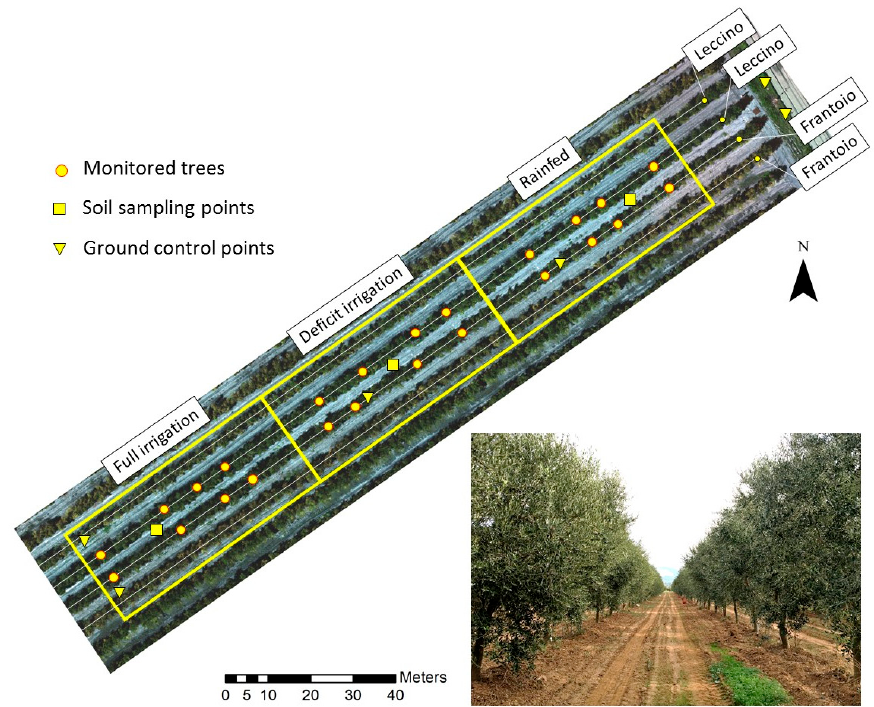
Figure 1. The olive orchard used for the experiment located at San Vincenzo (Livorno, 43.0551° N; 10.5490° E). The three yellow rectangles indicate the three irrigation treatments. Yellow dots, squares, and triangles indicate the monitored plants, soil sampling points, and ground control points, respectively.